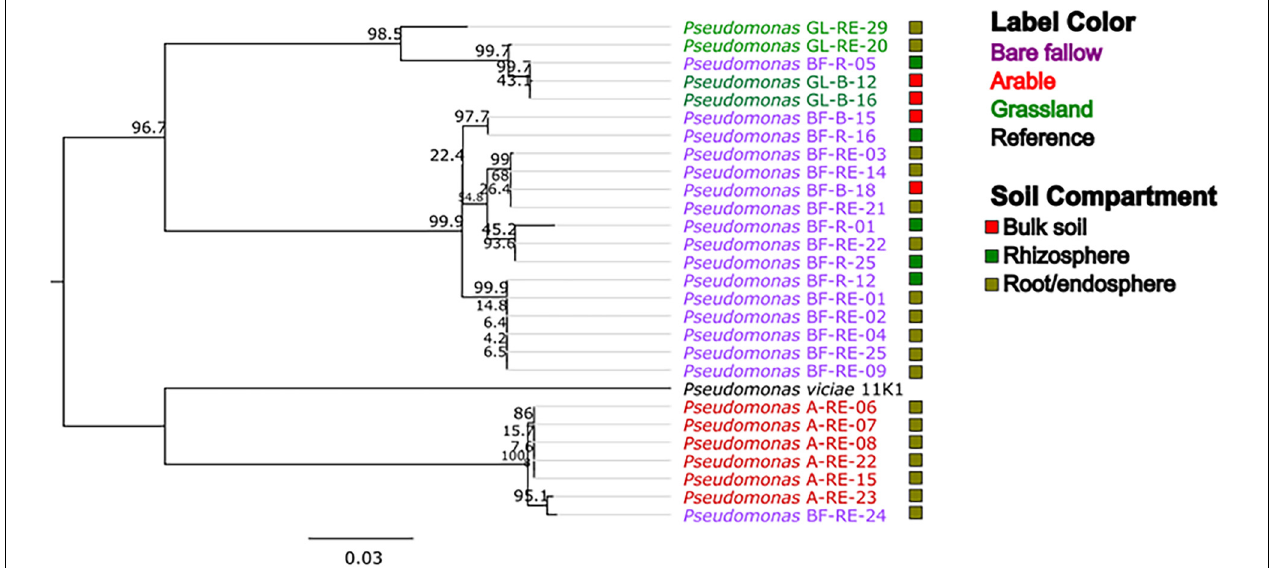
FIGURE 4 | Phylogeny of the acdS gene in pseudomonads from three different land managements. acdS sequences from bulk soil, rhizosphere, and roots associated with wheat grown in three distinct land management regimes (bare fallow, arable, and grassland) were phylogenetically analyzed utilizing a ML tree with a transitional model and 1,000 bootstraps in the software PhyML. Percentage bootstrap are indicated at branching nodes. Branch labels are colored to indicate the soil management where the bacteria was isolated and boxes beside labels indicate the soil compartment.